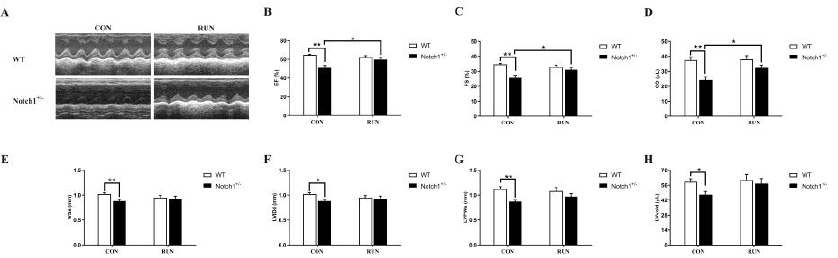
Figure 2. The cardiac function of all mice by echocardiography. ( A ): The representative pictures of echocardiography; ( B ): EF; ( C ): FS; ( D ): CO; ( E ): IVSs; ( F ): LVIDd; ( G ): LVPWs; ( H ): LVvold. IVSs: interventricular septum systolic thickness, LVIDd: left ventricular dimension in diastole, LVPWs: left ventricular posterior wall systolic thickness, EF: ejection fractional, FS: fractional shortening, LVvold: Left ventricular diastolic volume, CO: cardiac output per beat. WT CON: wild-type control mice; WT RUN: wild-type running mice; Notch1 +/ − CON: Notch1 heterozygote deficient control mice; Notch1 +/ − RUN: Notch1 heterozygote deficient running mice. Data are expressed as mean ± S.E.M. * p < 0.05, ** p < 0.01. n = 6–8 per group.